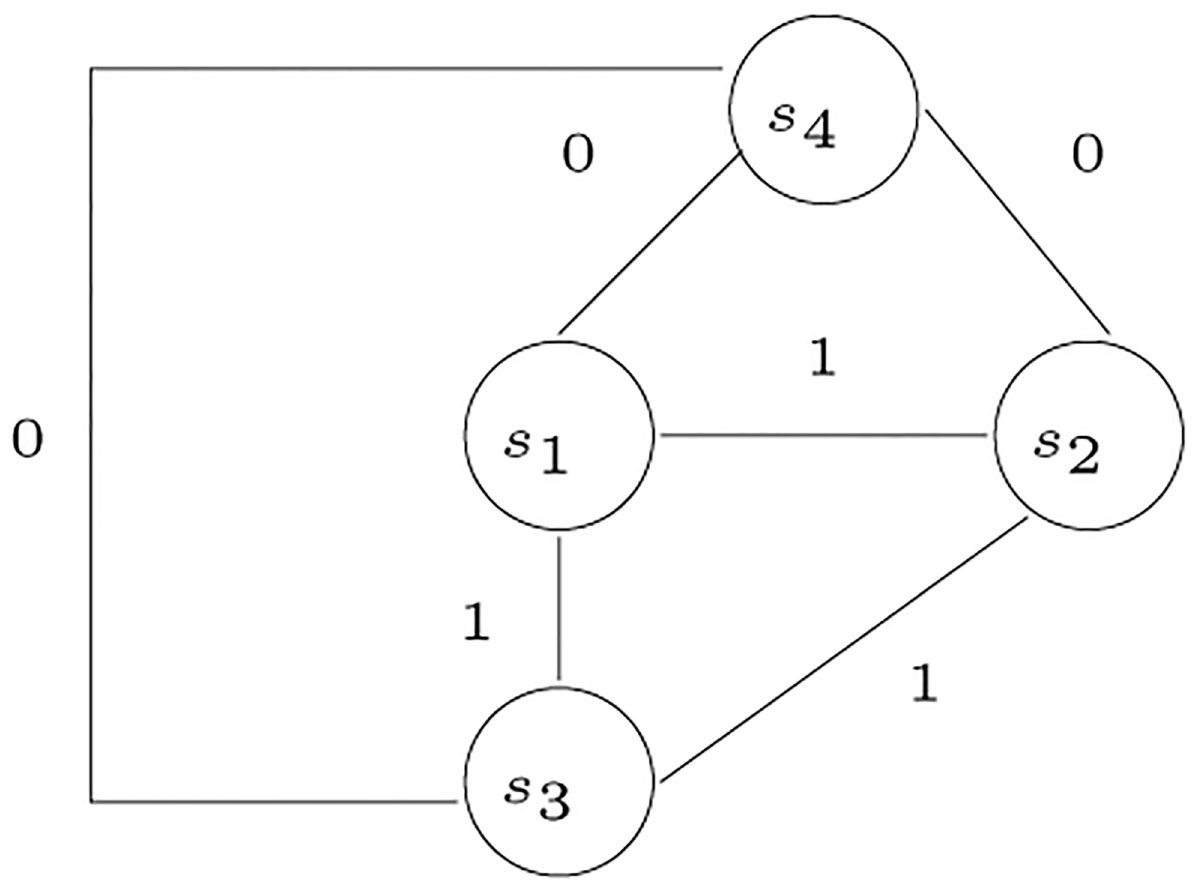
Fig 9. An undirected graph with cliques representing siblings.